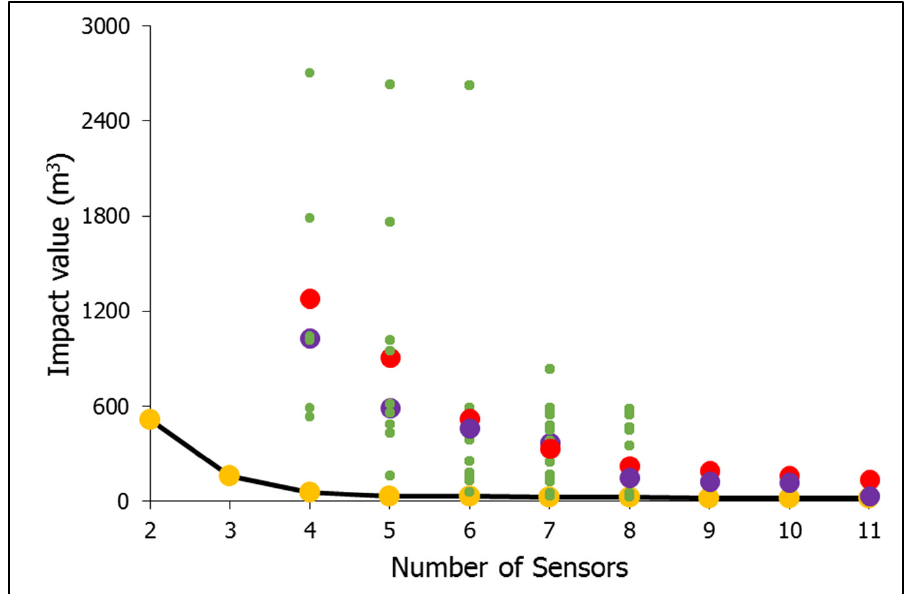
Figure 5. Variations in the impact values corresponding to scenarios under which the designed OCMS are subjected to cyber-physical attacks. The green circles indicate the impact values obtained for OCMS with η total = 4, 5, 6, 7, and 8. The red and violet circles signify the mean and median impact values, respectively. The black line with yellow circles denotes the mean impact values in the absence of a cyber-physical attack.